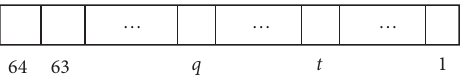
Figure. 4: Data format for 64-bit fixed-point numbers.